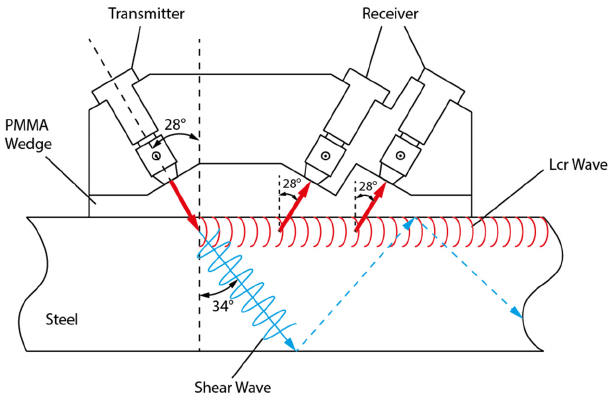
Figure 7. Typical set-up for generating 𝐿 (cid:3004)(cid:3019) wave.